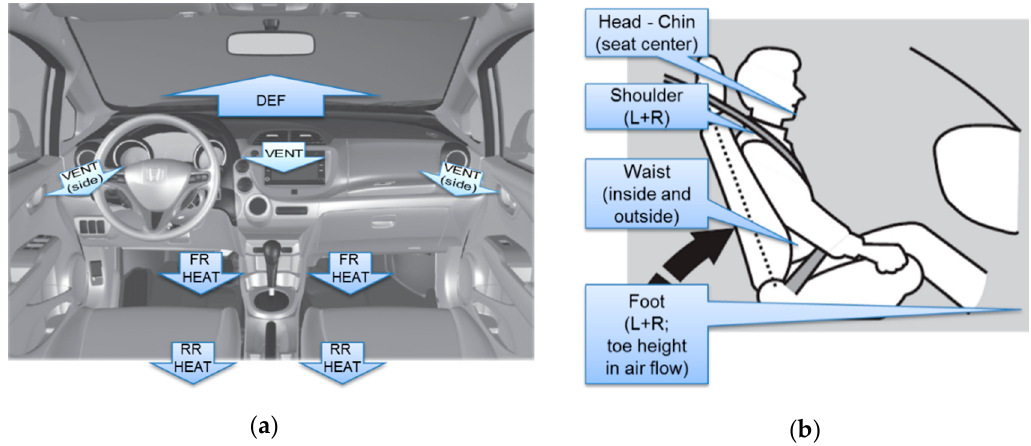
Figure 3. ( a ) Air outlet locations; and ( b ) temperature sensors’ position.